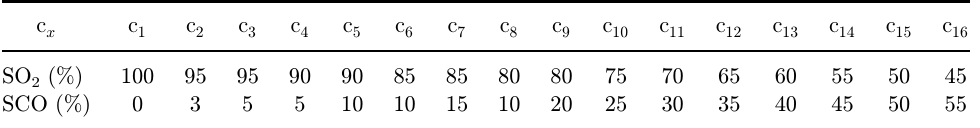
Table 1. Di®erent combinations of percent blood OxyHb (SO 2 ) and COHb saturation (SCO), c x , to give dermis absorption coe±cients used in post Monte Carlo